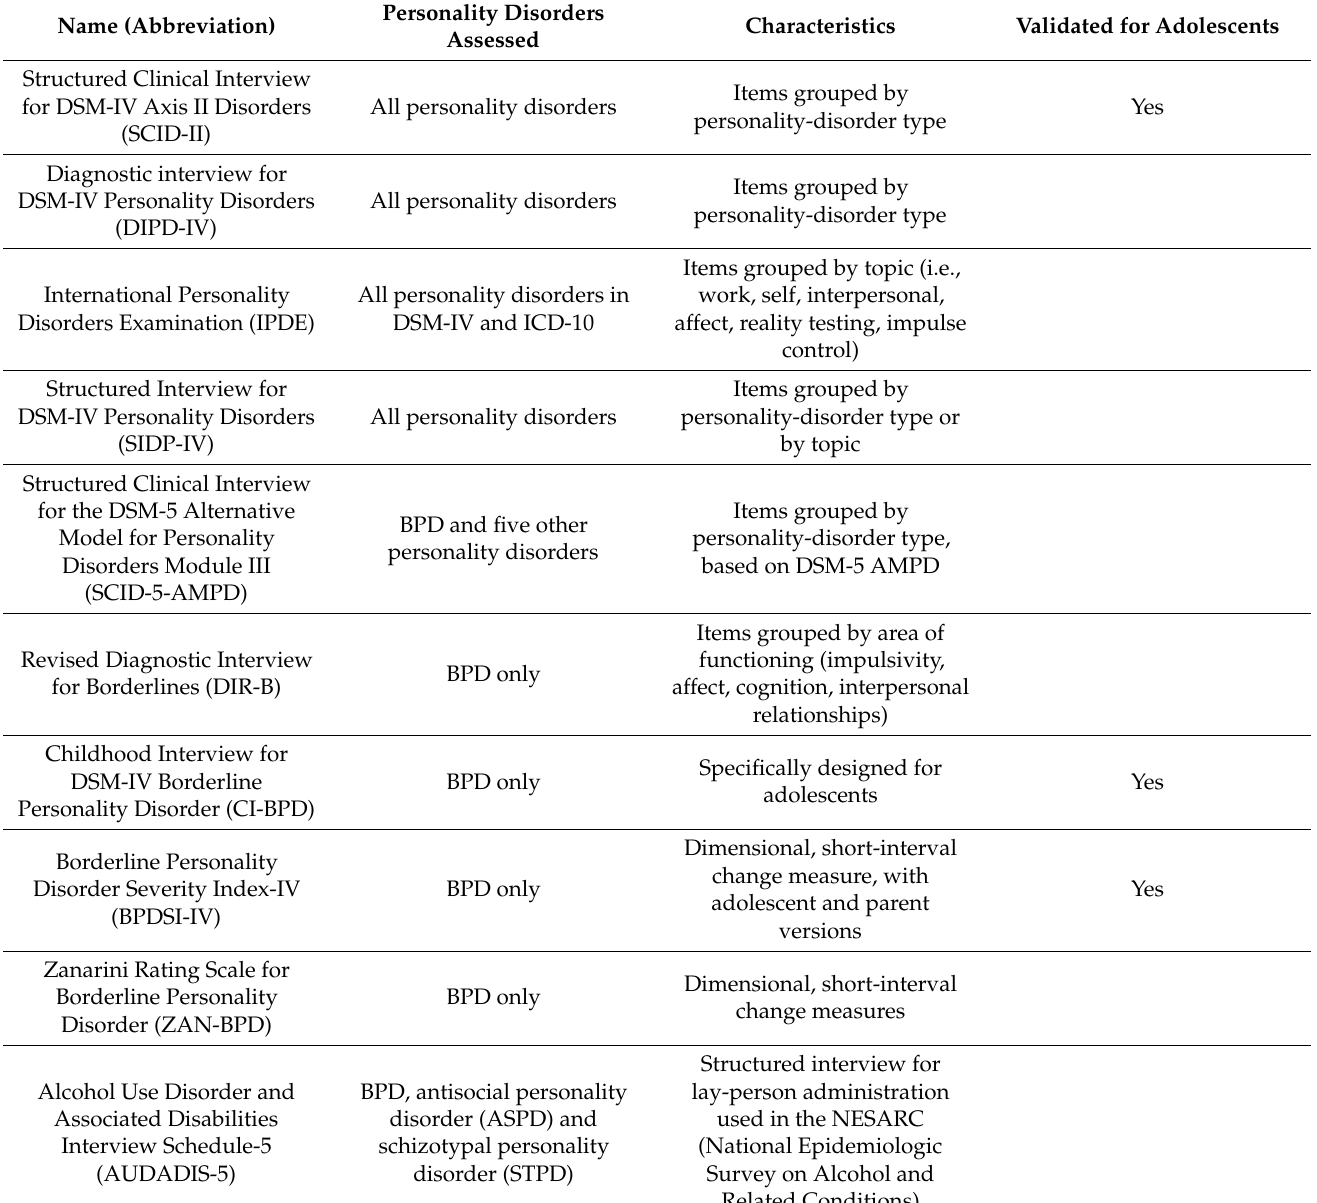
Table 5. Semi-structured